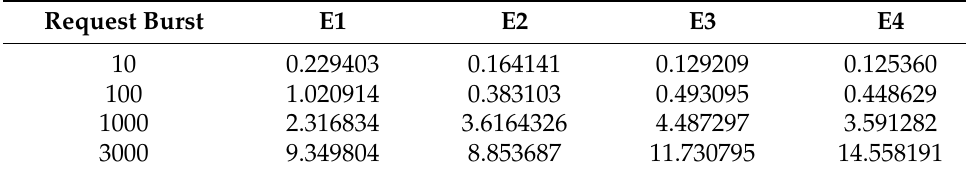
Table 2. Response time in front of different request rates.